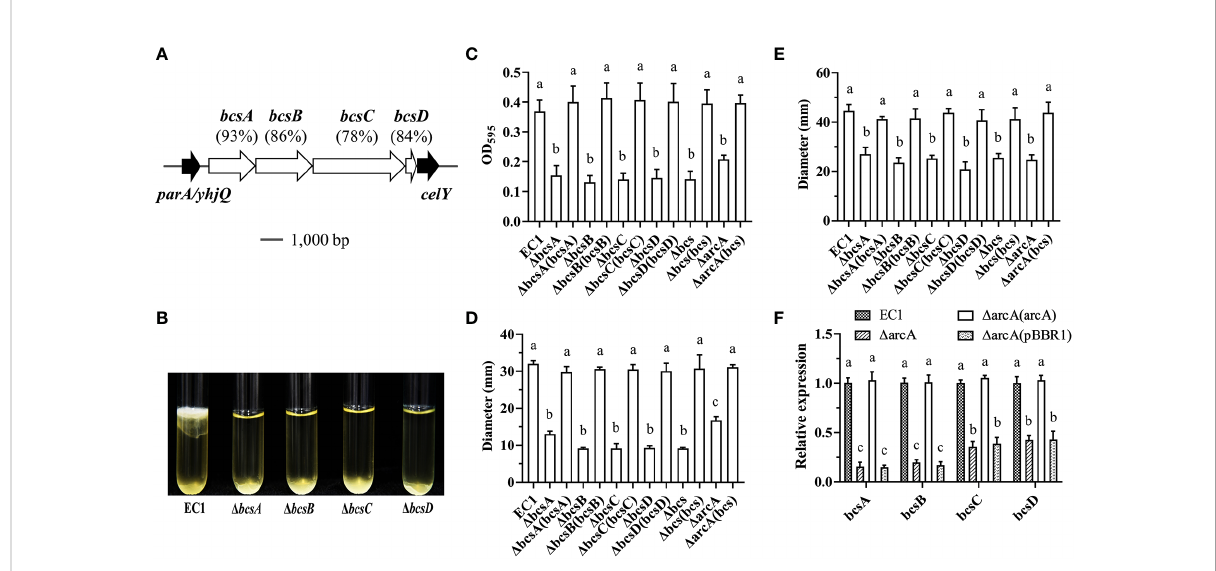
FIGURE 4 ArcA affects bacterial motility and bio fi lm formation by regulating the synthesis of celluloses. (A) Analysis of the homology and the locus of the cellulose encoding genes bcsABCD in D . oryzae EC1. (B) The qualitative analysis of bio fi lm formation in mutants of bcsA , bcsB , bcsC and bcsD . (C) Quanti fi cation of adherent bio fi lm biomass in wild-type strain EC1, D bcsA, D bcsB, D bcsC, D bcsD, D bcs and D arcA(bcs) using crystal violet staining. (D) The swimming motility of wild-type strain EC1, D bcsA, D bcsB, D bcsC, D bcsD, D bcs and D arcA(bcs). (E) The swarming motility of wild-type strain EC1, D bcsA, D bcsB, D bcsC, D bcsD, D bcs and D arcA(bcs). (F) The gene expression of bcsA , bcsB , bcsC and bcsD in strains D arcA and D arcA(pBBR1). The experiments were repeated three times in triplicate and the error bars indicate standard deviation. The statistical